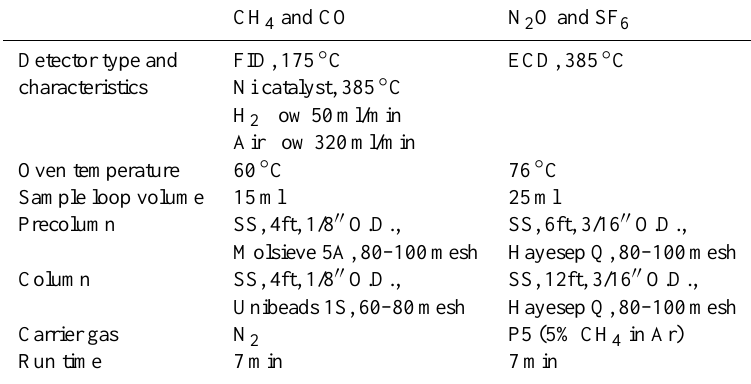
Table 1. GC measurement